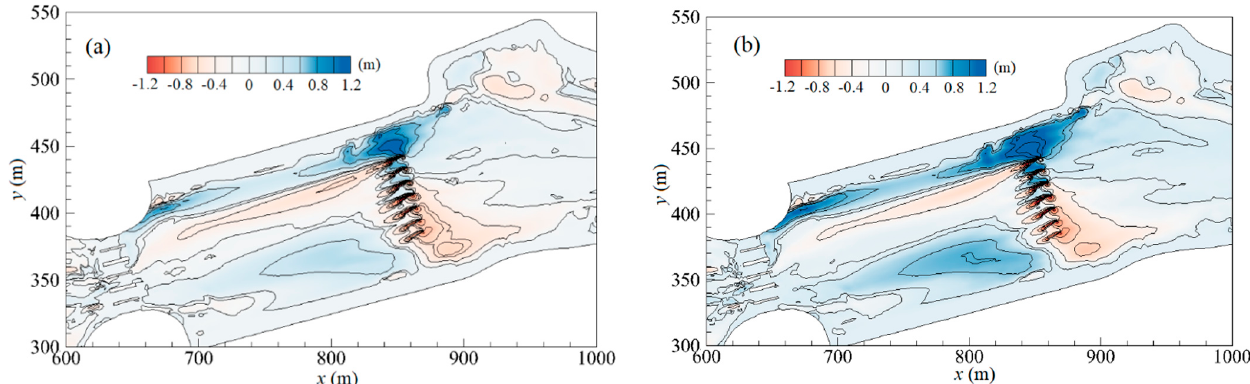
Figure 15 . Riverbed changes in the reservoir with the installation of seven guide vanes, all aligned at α = 15°. ( a ) case 1; ( b ) case 2. Compared with the 2015 river bathymetrical data, a positive value denotes erosion and a negative one deposition.